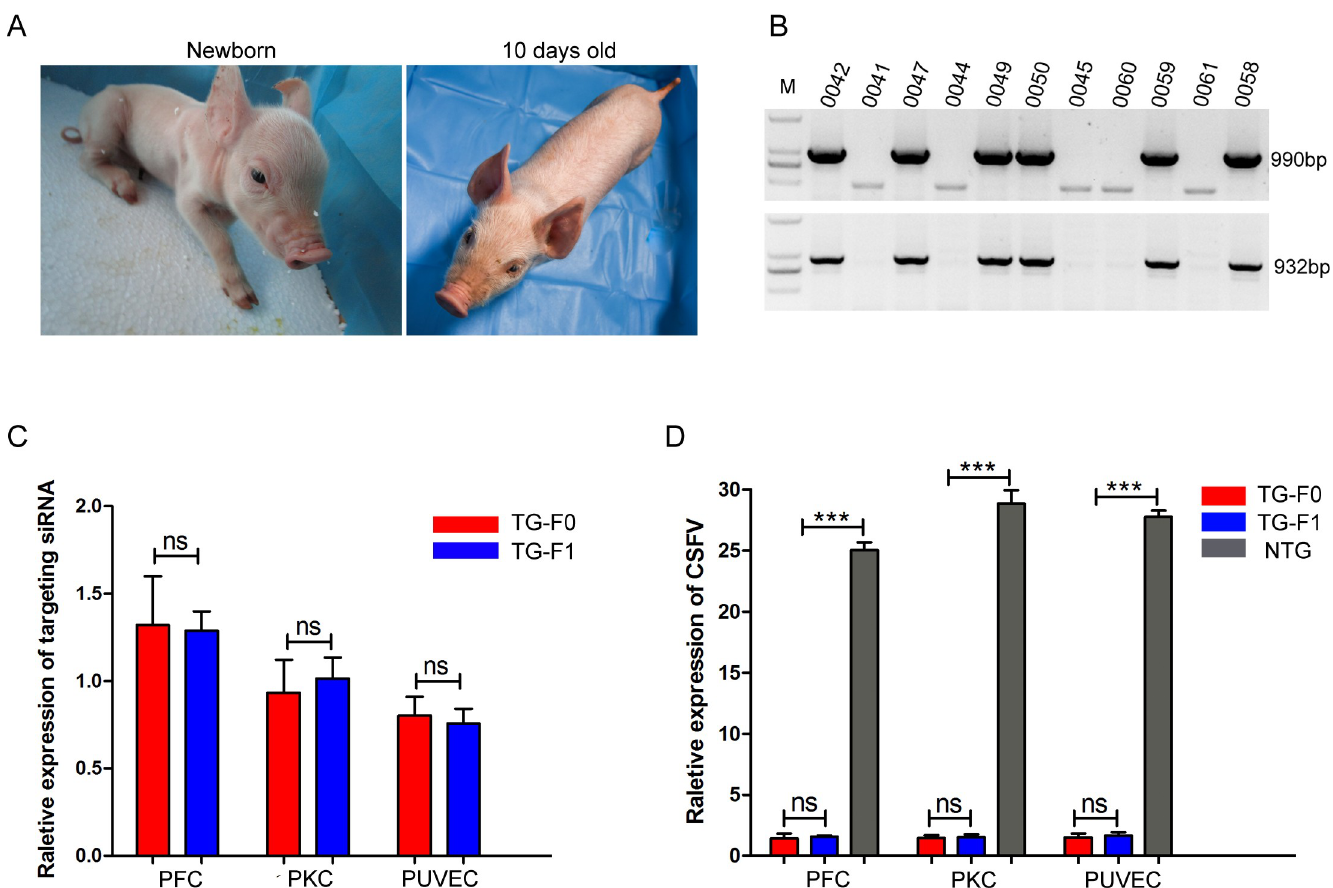
Fig 4. Generation of F1-generation TG pigs. (A ) Photographs show one of the F1-generation TG piglets. ( B ) The knock-in events in newborn TG piglets were confirmed by genomic PCR. Pigs 0042, 0047, 0049, 0050, 0058 and 0059 are TG pigs, and pigs 0041, 0044, 0045, 0060 and 0061 were NTG. M, DNA marker (D2000, Tiangen, Beijing, China). ( C ) The relative expression levels of the targeting siRNA in F0- and F1-transgenic cells were compared by qPCR. Targeting siRNA expression levels were analysed with the unpaired t-test (ns. not significant). Error bars represent the SEMs, n = 3. TG-F1 represents F0-generation TG pigs. TG-F1 represents F1-generation TG pigs. ( D ) qPCR results show the relative expression of viral RNA in NTG cells, F0-generation TG cells and F1-generation TG cells. Viral RNA expression was analysed with an unpaired t-test (ns. not significant; ��� p < 0.001). Error bars represent the SEMs, n = 3.